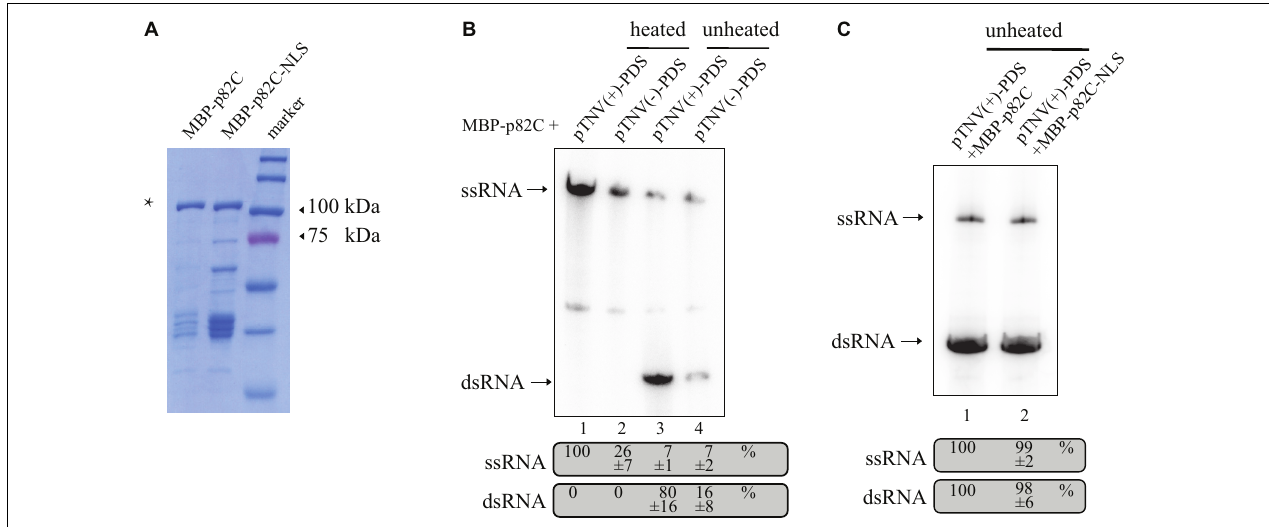
FIGURE 2 | In vitro RdRp assay to test the activity of promoters of TNV-A. (A) Purified recombinant MBP-p82C and MBP-p82C-NLS analyzed by SDS-PAGE and Coomassie blue staining. The band of MBP-p82C or MBP-p82C-NLS is marked with an asterisk. (B) The non-denaturing PAGE analysis of complementary RNA synthesized by MBP-p82C under the control of TNV-A positive- or negative-strand RNA initiation promoters. The ssRNA band of lane 1 was chosen as 100%. The experiment was repeated three times. (C) The non-denaturing PAGE analysis of complementary RNA synthesized by MBP-p82C or MBP-p82C-NLS under the control of TNV-A positive-strand RNA initiation promoter. The ssRNA and dsRNA bands of lane 1 were chosen as 100%, respectively. The experiment was repeated three